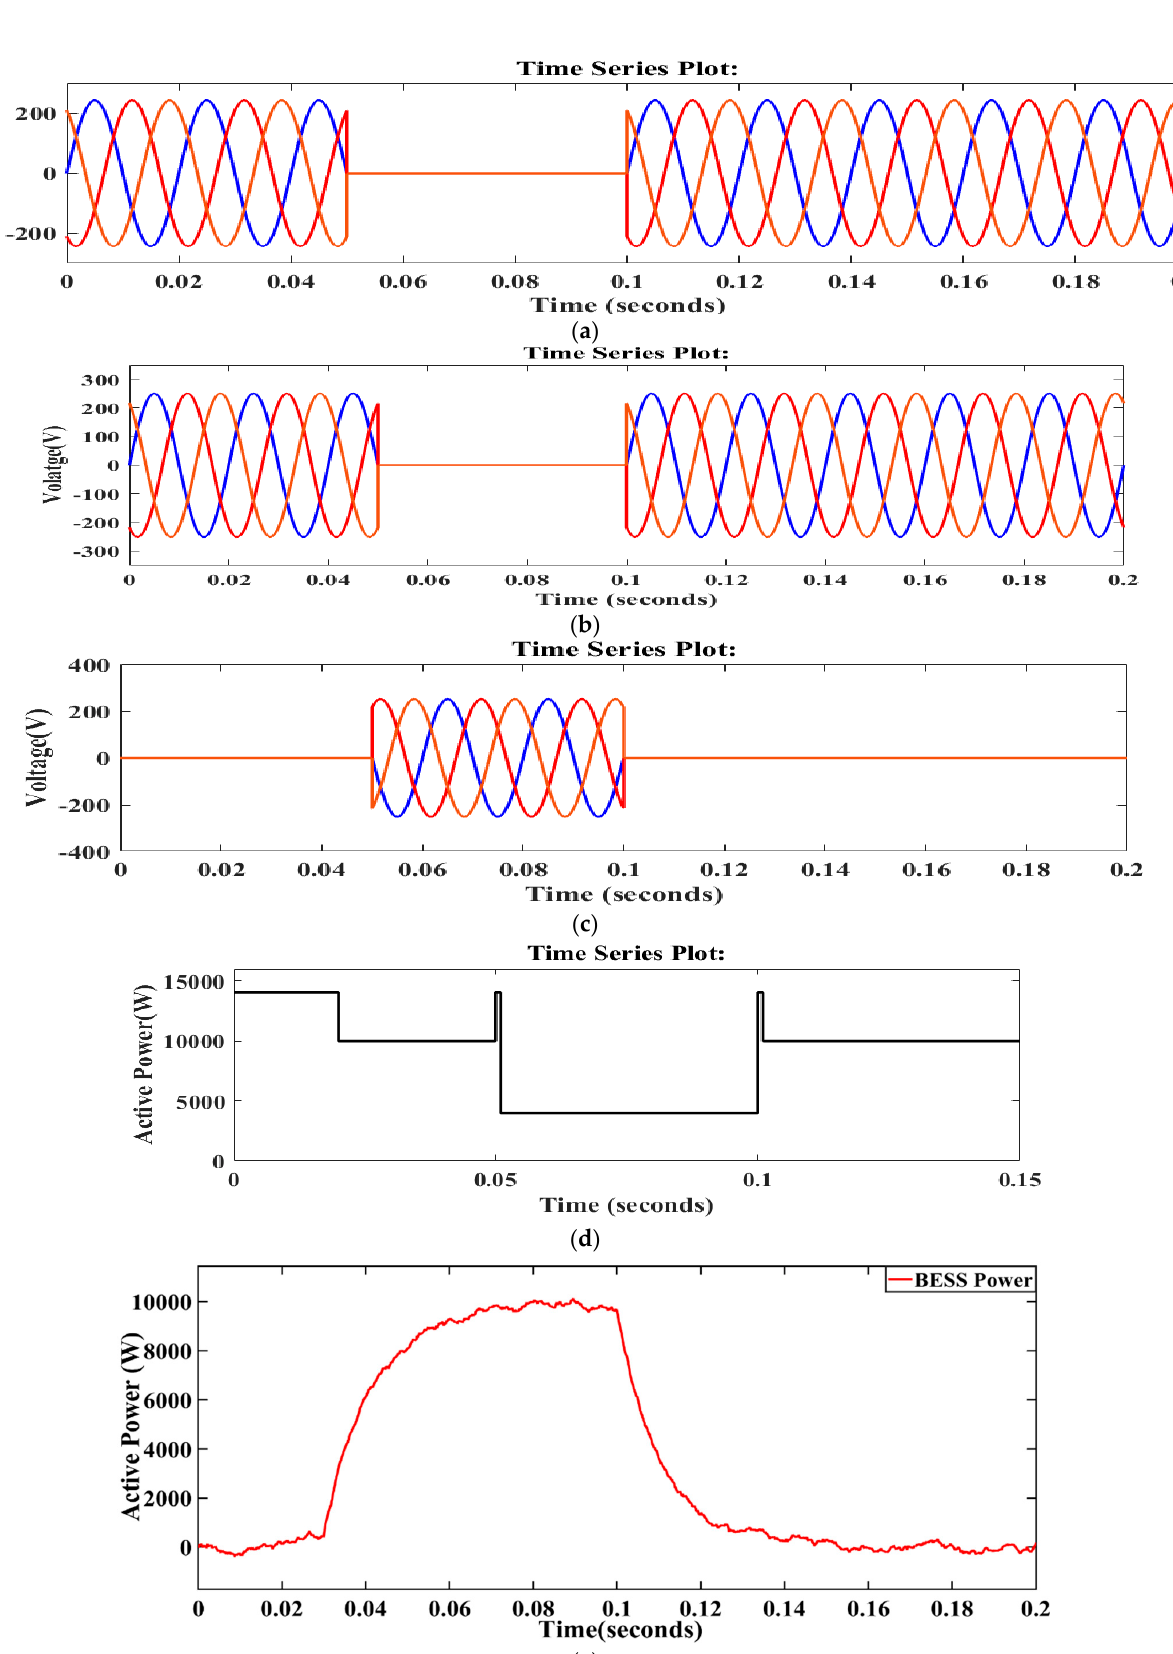
Figure 15. ( a ). Voltage delivered by DER1, DER2, and DER3. ( b ) Voltage supplied by utility grid. ( c ) Voltage supplied by BES system. ( d ) Sharing of power by load. ( e ) Active power supplied by